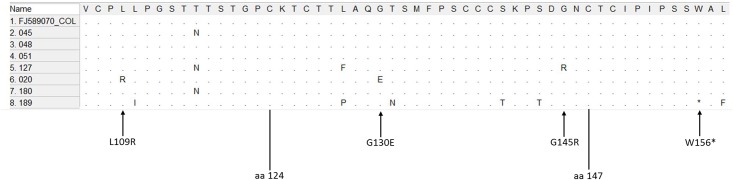
Alignment of amino acids corresponding to the major hydrophilic region (MHR) sequence of HBsAg of HBV, using the MEGA 5.05 software.The samples 020_SJ Atacuari_AM, 045_SJ Atacuari_AM, 048_Naranjales_AM, 051_Pto Esperanza_AM, 127_Boyahuazi_AM, 180_Pto Esperanza_AM and 189_Tarapacá_AM, were aligned with the reference sequence FJ589070.1 from GenBank. Arrow: identified escape mutants and potential escape mutants, amino acids 124–147: “a” determinant.